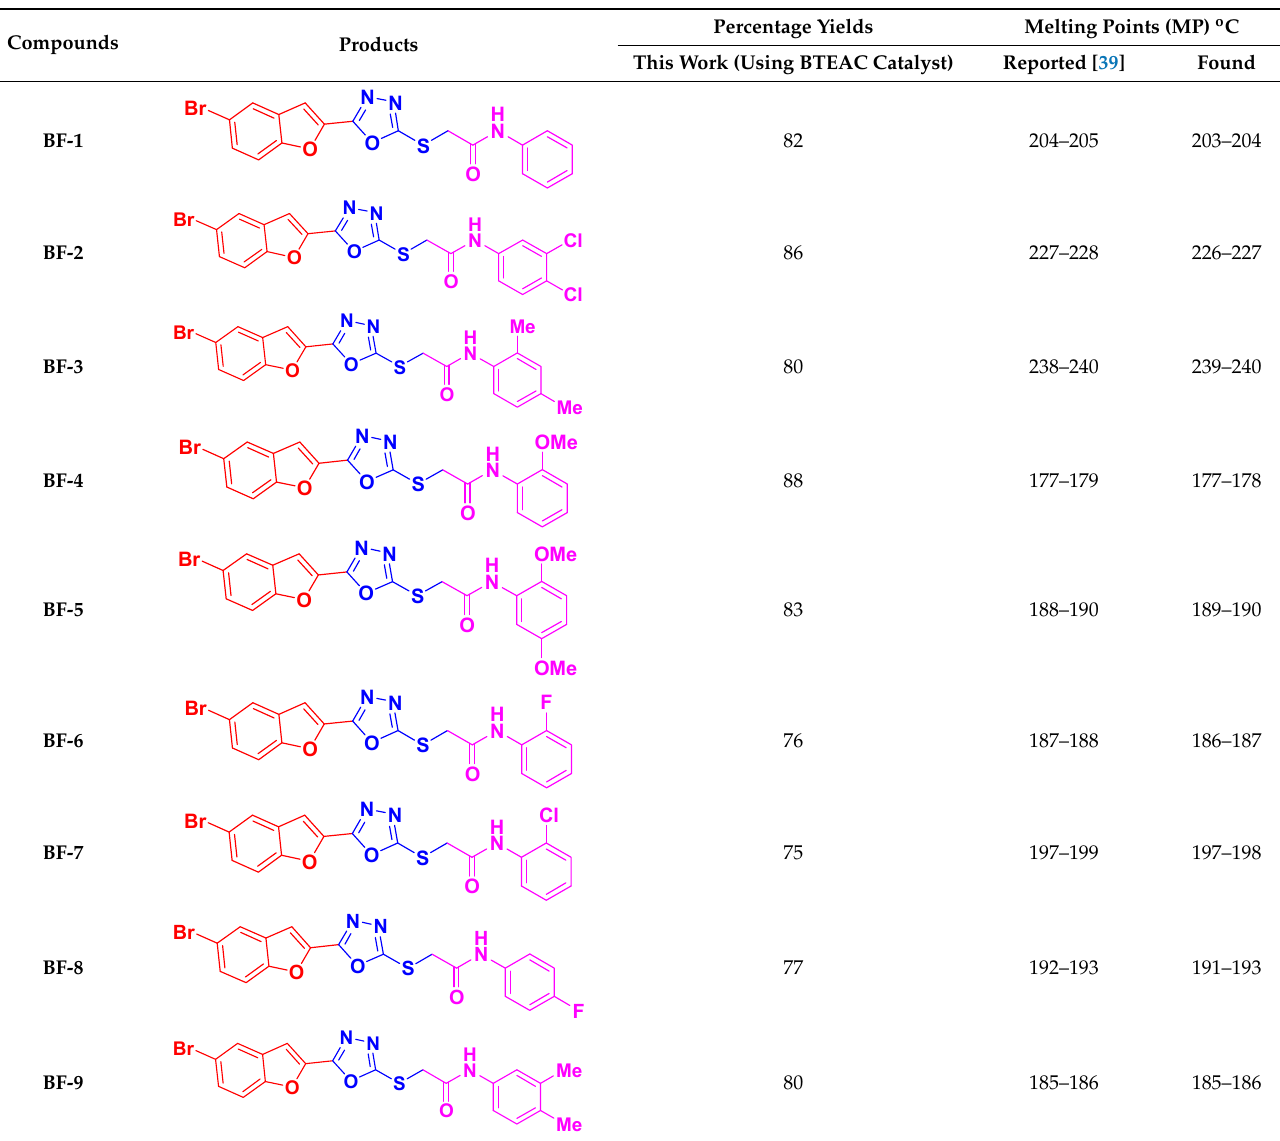
Table 1. Synthetic data of bromobenzofuran-oxadiazole derivatives BF1-9 .